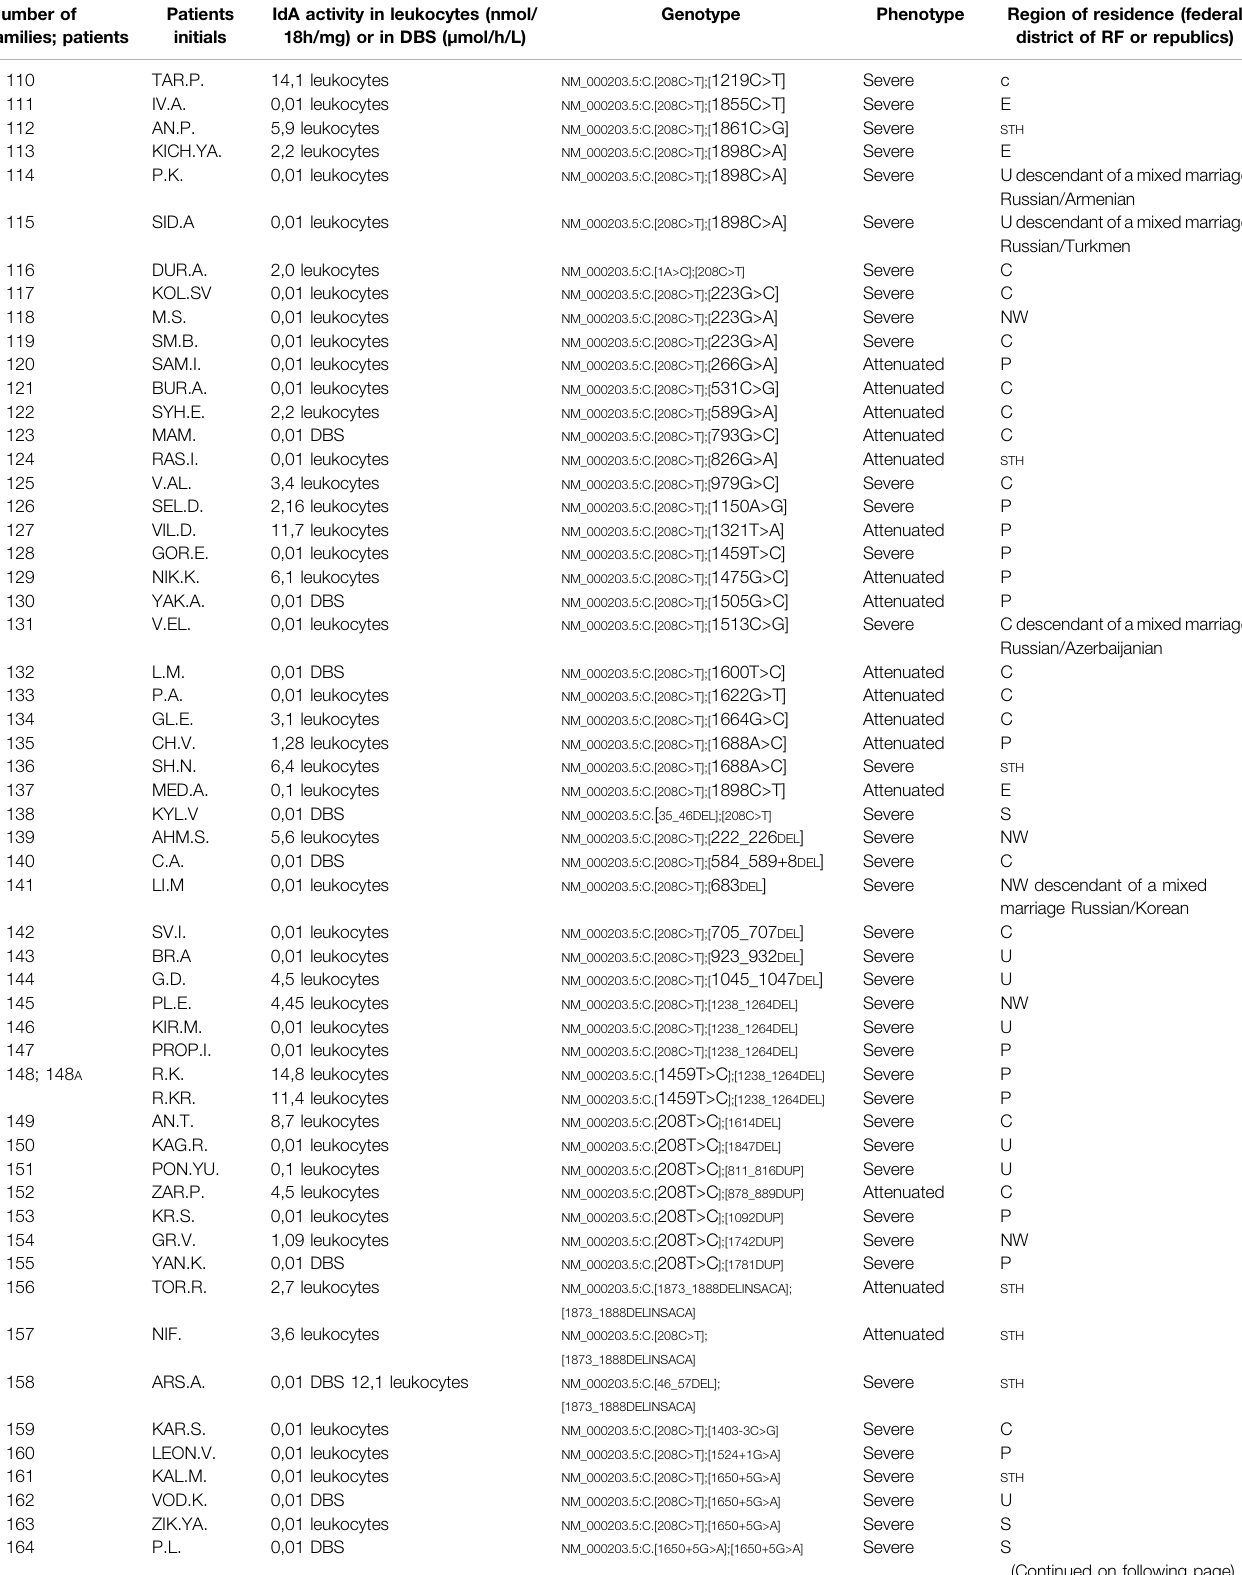
TABLE 1 | ( Continued ) Genotype and phenotype of patients with an indication of the place of residence and nationality. Number of families;